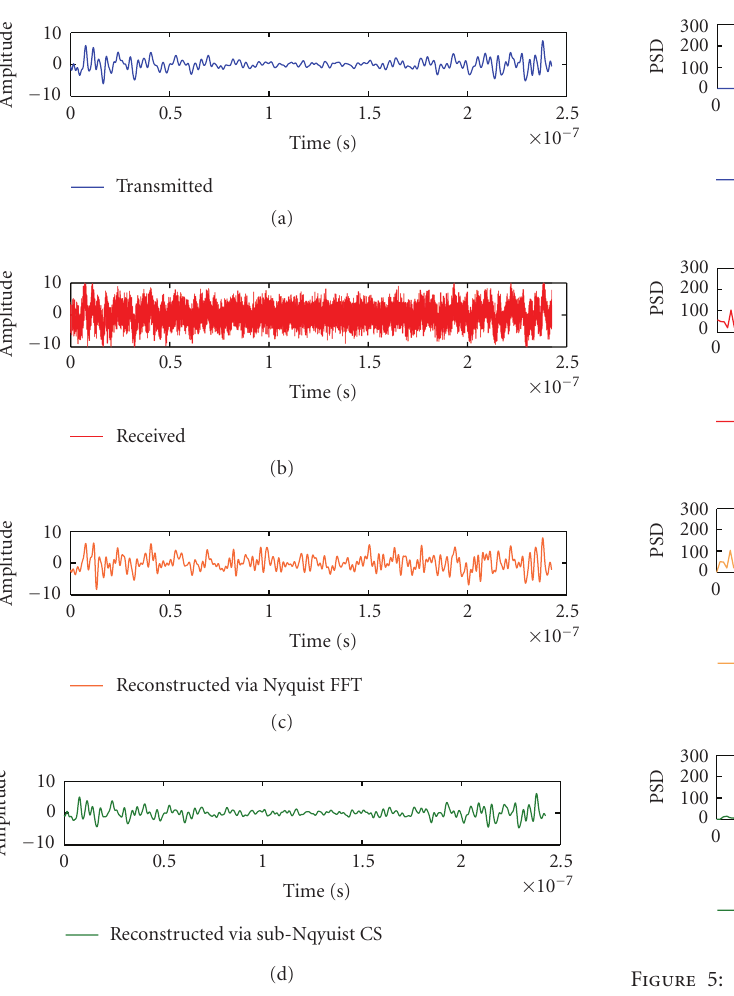
Figure 4: Time-domain signals of a simulated multiband signal. From top to bottom, the four plots represent the transmitted signal by primary users, the received primary users’ signal at the sensing radio, the reconstructed signal from the time-domain samples via the Nyquist rate ADC, and the reconstructed signal from the transform-domain samples via mixed-CS at an NSR of 0 . 32.